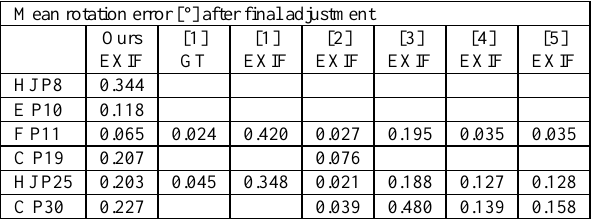
Table 3. Comparison of mean rotation errors after final bundle